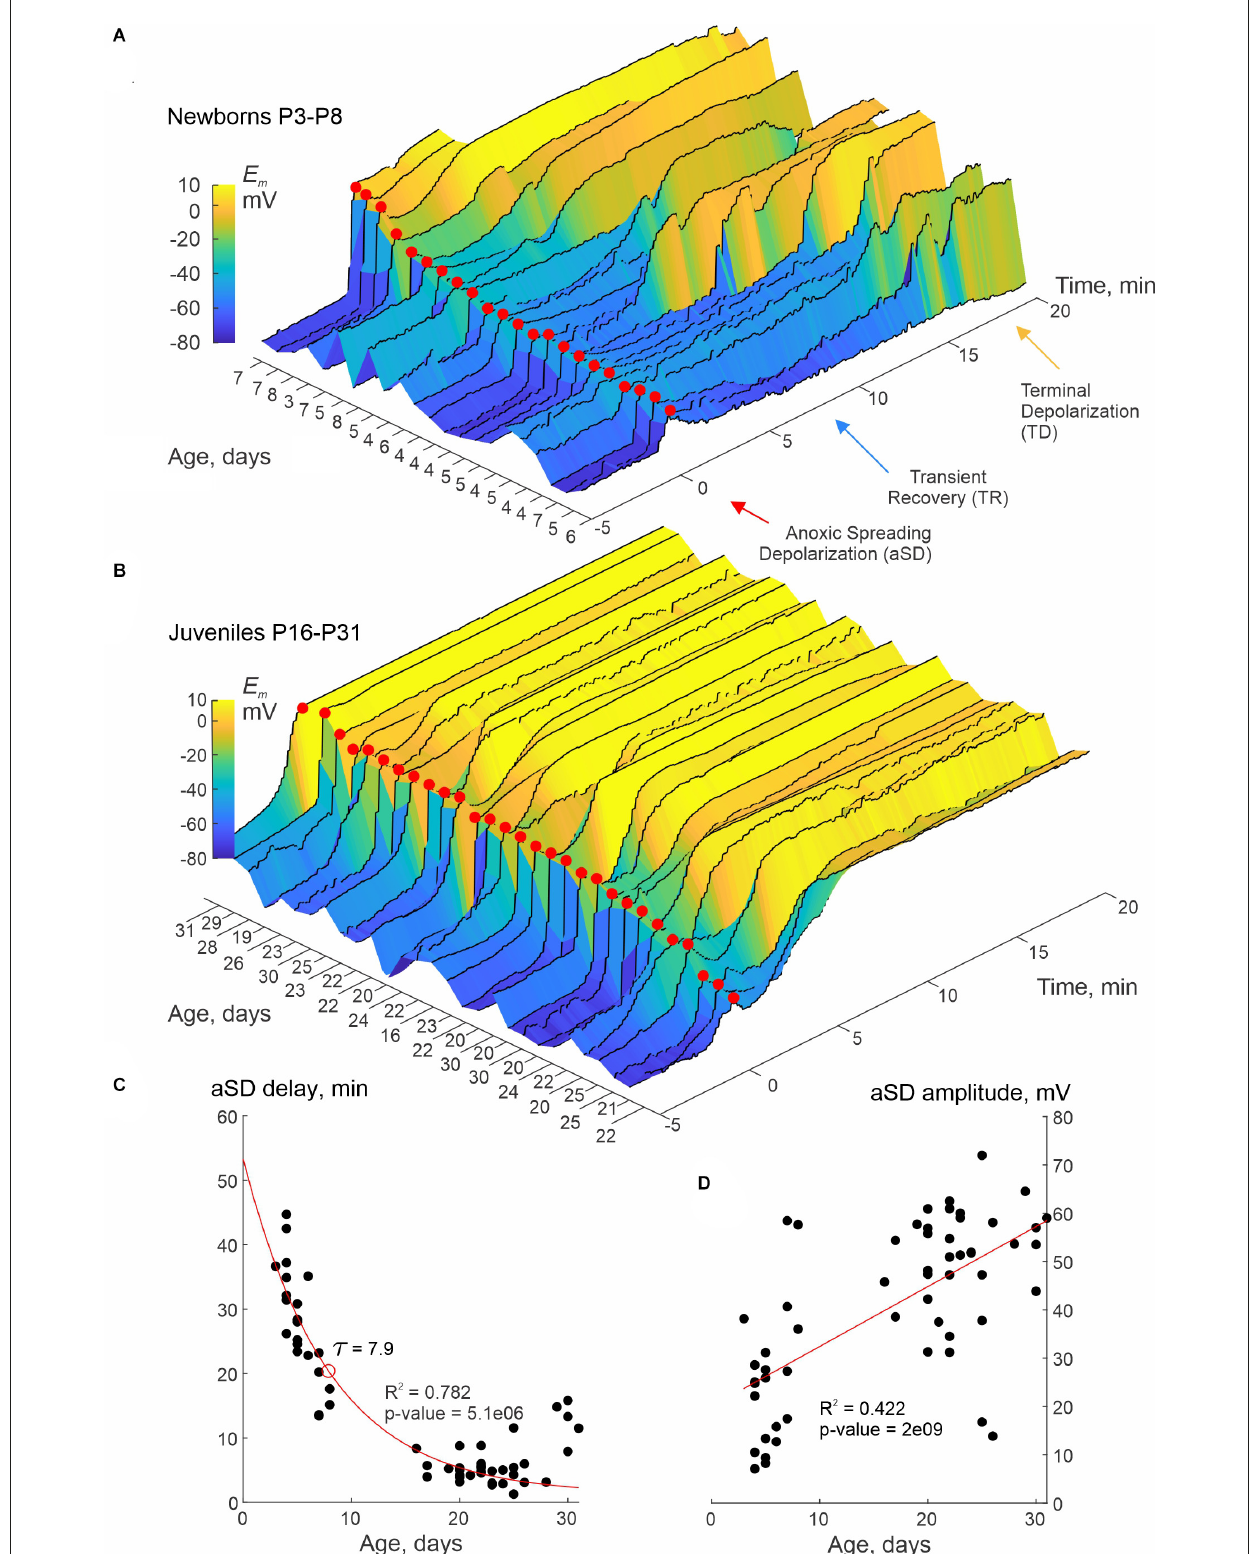
FIGURE1 Smaller aSD amplitude and transient recovery of membrane potential in neurons of newborn rat cerebral cortex. (A,B) Dynamics of membrane potential ( E m ) in L4 neurons recorded in whole-cell current-clamp mode during oxygen-glucose deprivation (OGD) in slices of somatosensory cortex prepared from neonatal (P3–8) (A) and juvenile (P16–31) (B) rats. The E m signal was low-pass filtered with a median filter using a sliding